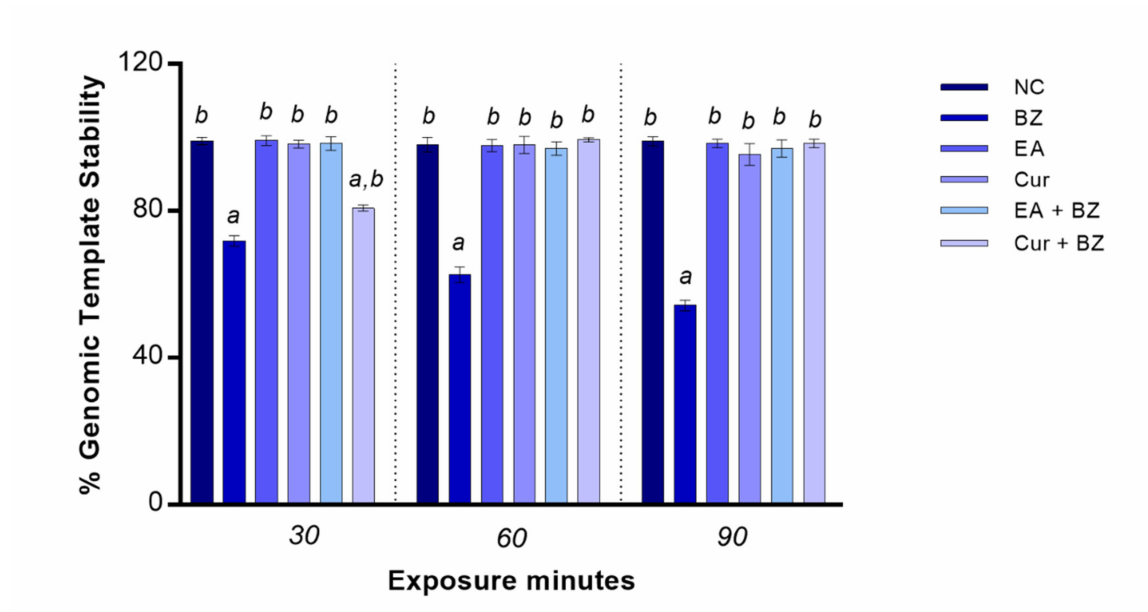
Figure 4. Changes in percentage of genome template stability (y-axis) in zebrafish blood cells DNA at different exposure times (x-axis). Benzene—BZ; Ellagic acid—EA; curcumin—Cur; negative controls—NC. Letters correspond to diverse statistical significances (ANOVA); a : p < 0.05 in comparison with NC; b : p < 0.05 in comparison with BZ